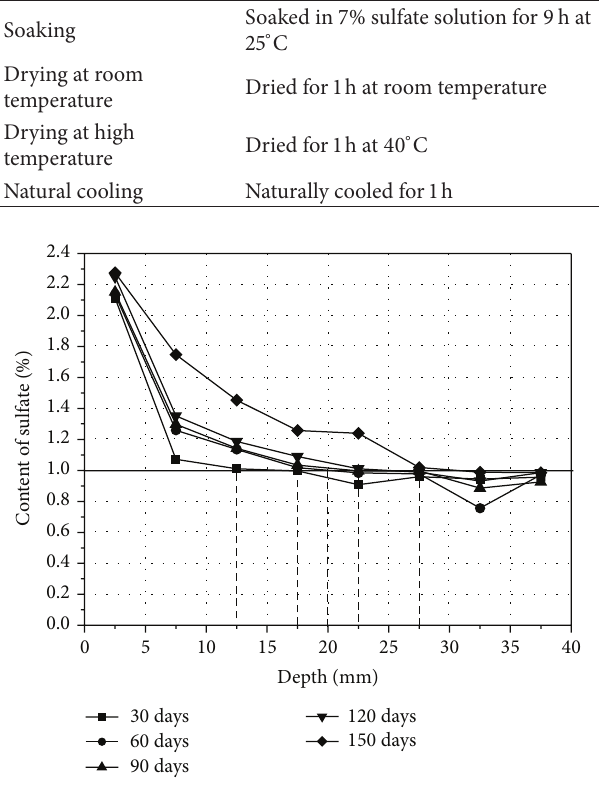
Figure 2: Distribution law of sulfate ions in